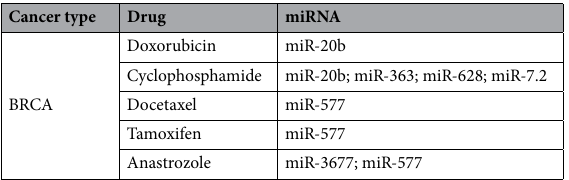
Table 4. Predictive miRNAs identified in BRCA-drug